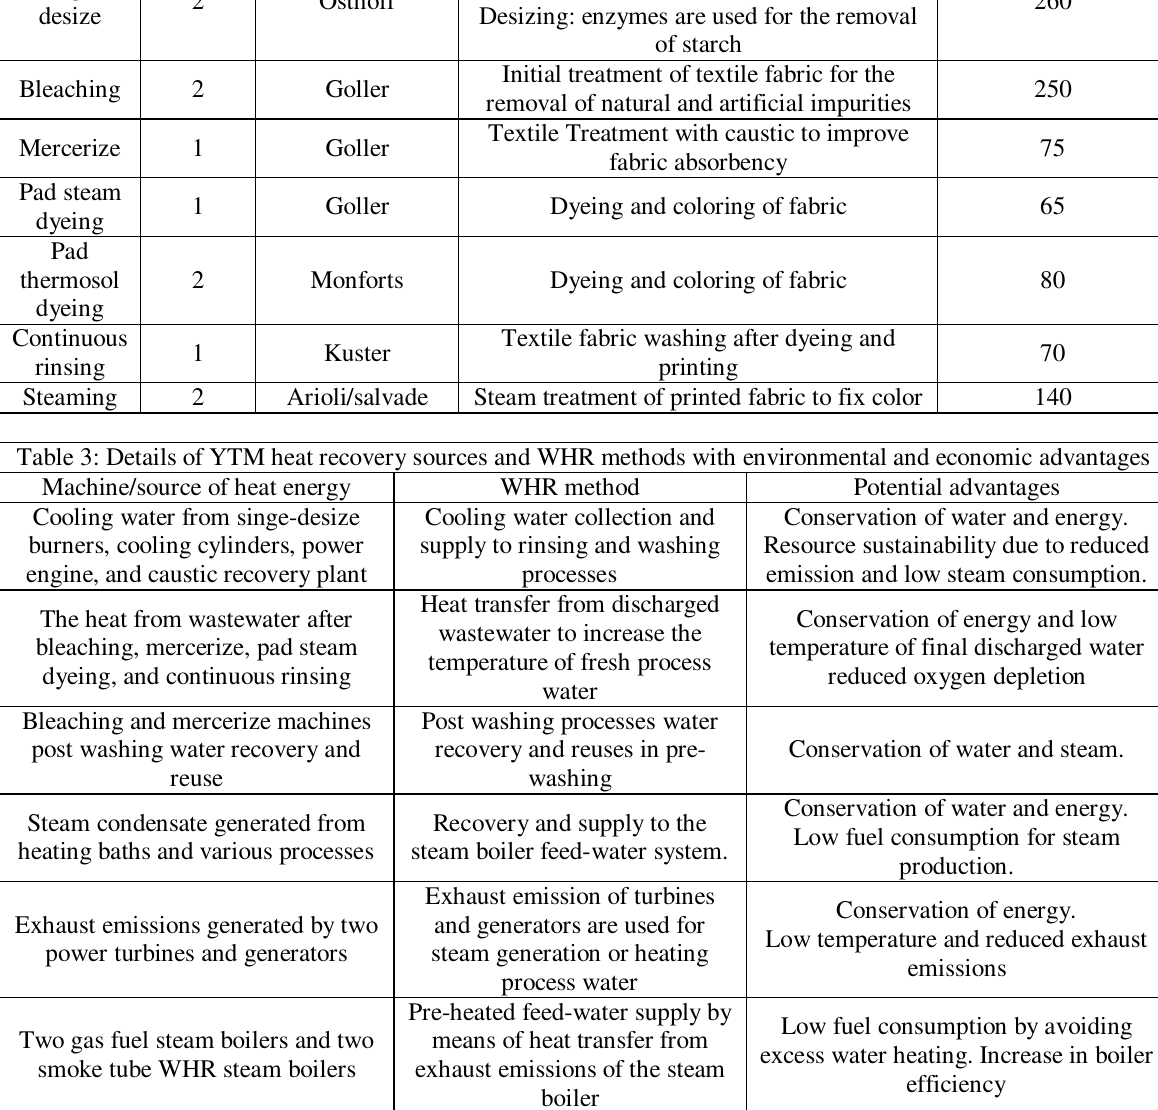
Table 2: Details of YTM Wet-Processing